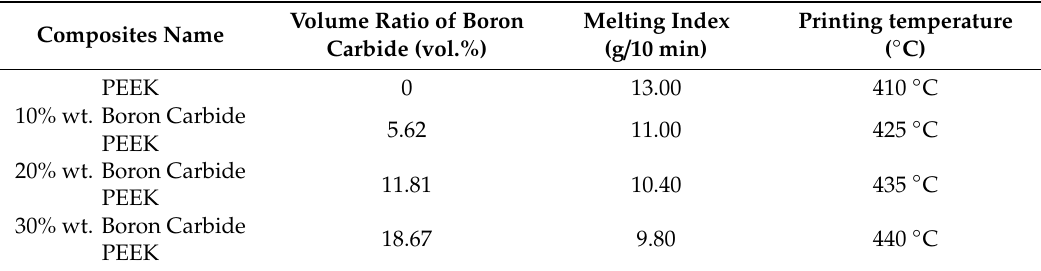
Table 1. Fused deposition modeling (FDM) temperature parameters of boron carbide polyether-ether- ketone